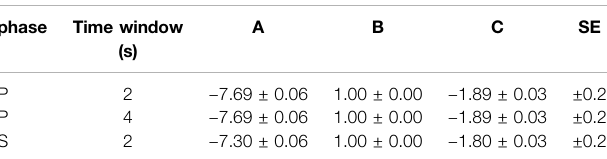
TABLE 1 | Coef fi cients (A, B, C) and SE of the RTMag regression law used in this study for PRESTo (Festa, not published, implemented in the available release of the PRESTo